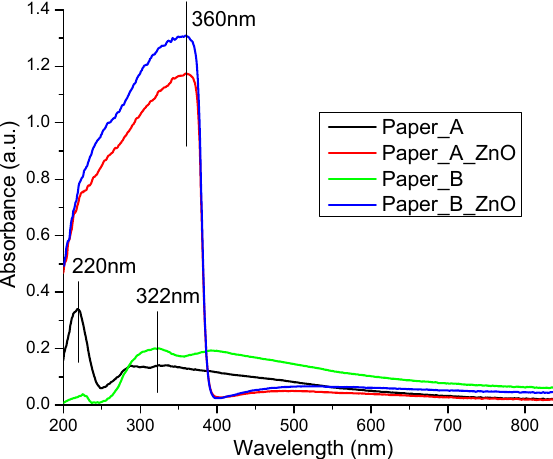
Figure 12. UV-Vis spectra for paper samples before and after ZnO treatment.